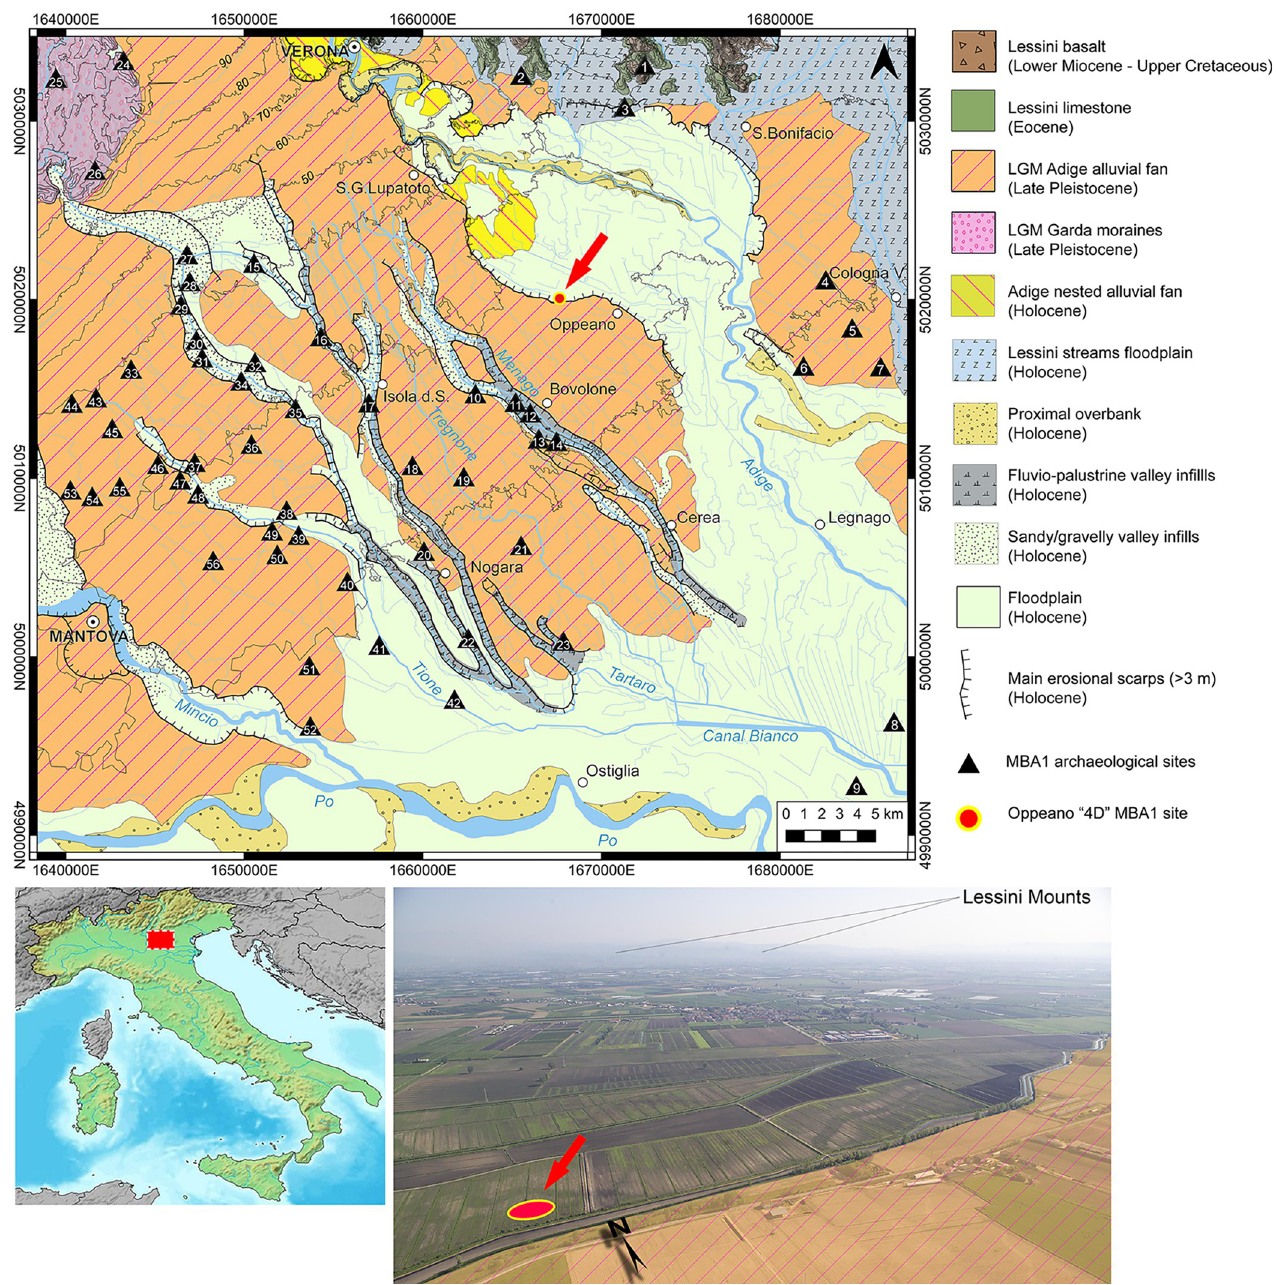
Fig 1. Geomorphological map showing the floodplain between the Lessini foothill and the present-day Po River. The map is based on: [35, 36], and Carta Geologica d’Italia 1:100.000 sheets n˚ 48, 49, 62, 63. The image of Italy in the lower left corner was obtained from Natural Earth (public domain— naturalearthdata.com). Fig 1 shows the position of the known EBA 2-MBA 1 and MBA 1 settlements (i.e., contemporaneous to Oppeano 4D; based on [37– 40]): (1) Monte Castejon; (2) Corte Palu`; (3) Monte Rocca; (4) Veronella–via Roversello 19; (5) Fondo Lora-Buratti; (6) Cimitero di Caselle; (7) Bernardine di Coriano; (8) Stanghelletti; (9) Marola; (10) Novarina; (11) Pr à Longo di Tarmassia; (12) Le Gesiole; (13) Saccavezza; (14) Scolon di Saccavezza; (15) Isolalta; (16) Panzana; (17) Mulino Giarella; (18) Pellegrina; (19) Corte Olmi; (20) Montalto; (21) Barab ò - via Barab ò ; (22) Il Mulino; (23) Maccacari–Quartieri Nord; (24) Monte Corno; (25) Torbiera Cascina; (26) La Palu` di Sommacampagna; (27) Grezzanin; (28) La Muraiola di Povegliano; (29) Grezzano–Ortigara; (30) Pr à grande; (31) I Camponi–Nogarole Rocca; (32) Corte Braette; (33) Mozzecane–Quarto del Tormine; (34) Corte Vivaro; (35) Castello di Trevenzuolo; (36) Corte Il Dazio; (37) Traversoni; (38) Demorta; (39) Susano; (40) Pomella; (41) Corte Carnarola; (42) Finilone Valle; (43) Castiglione Mantovano; (44) Roverbella; (45) Prestinari; (46) Canedole; (47) Corte Bertola; (48) Castelbelforte; (49) Cimitero di Bigarello; (50) Casazza; (51) Roncoferraro; (52) Casaletto; (53) Corte Pero; (54) Santa Lucia; (55) Fornasotto; (56) Corte Gandolfa.